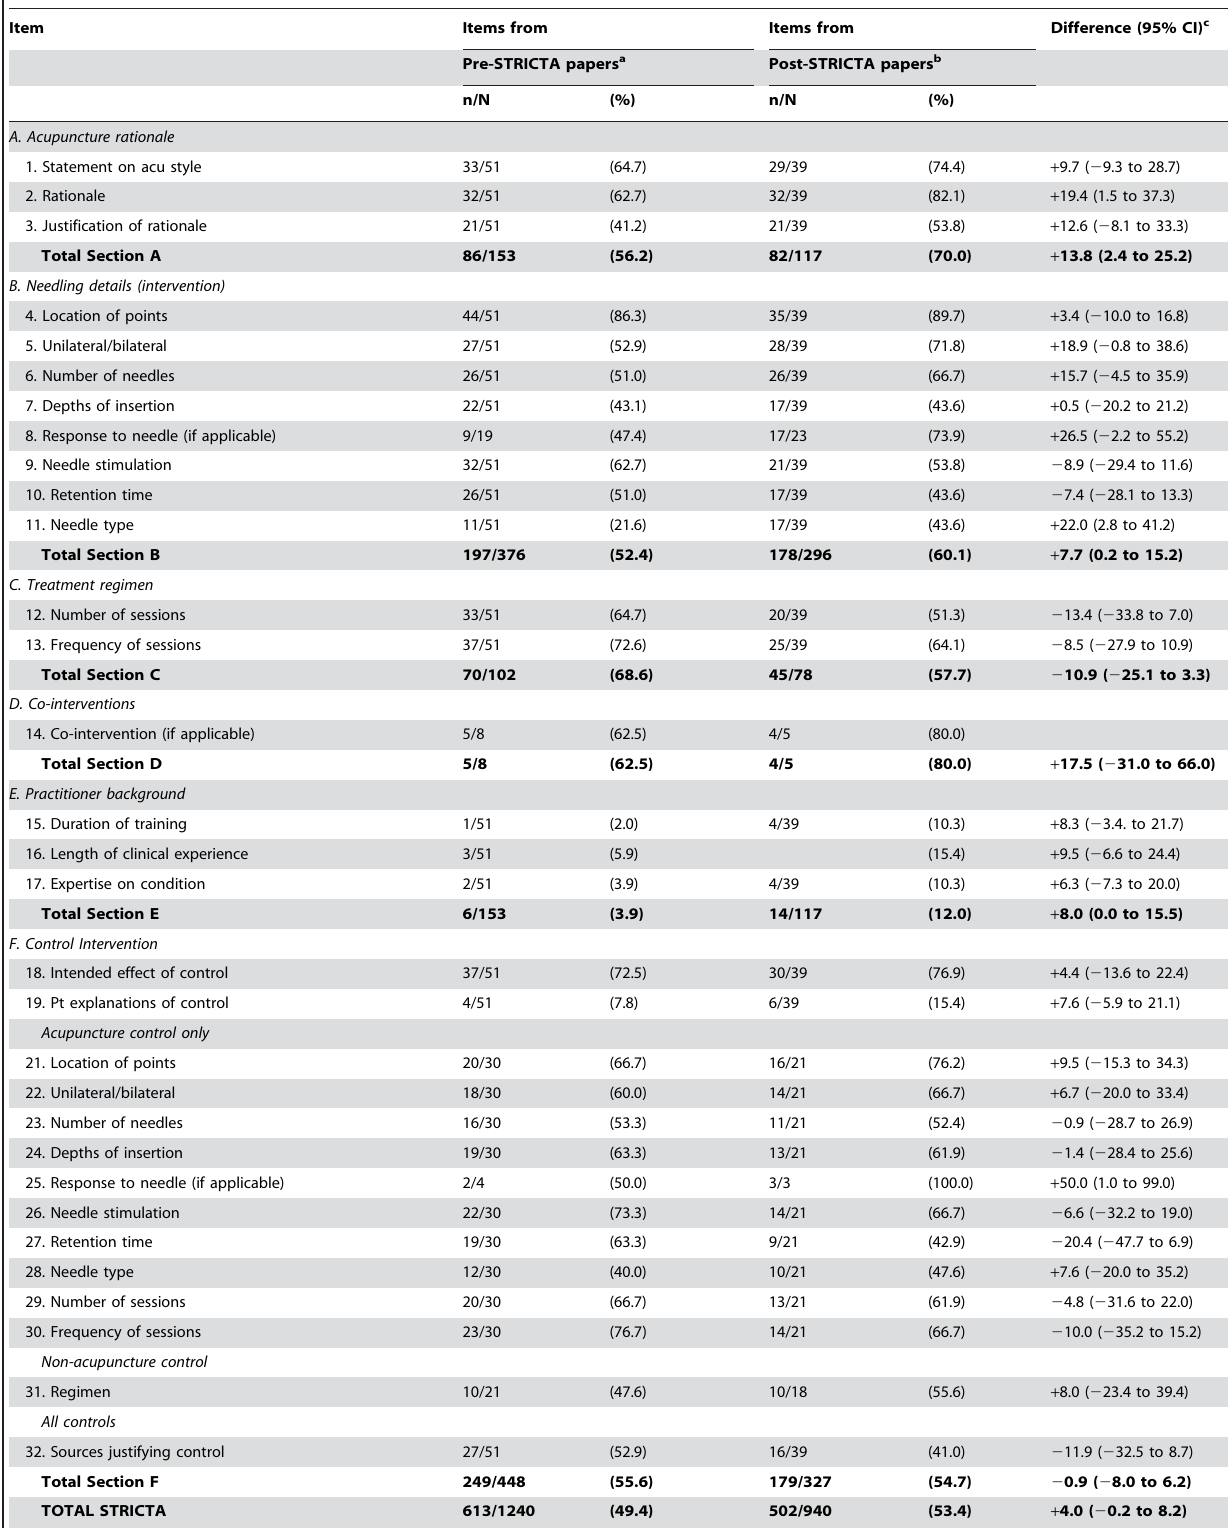
Table 3. Reporting of STRICTA items and change in reporting over